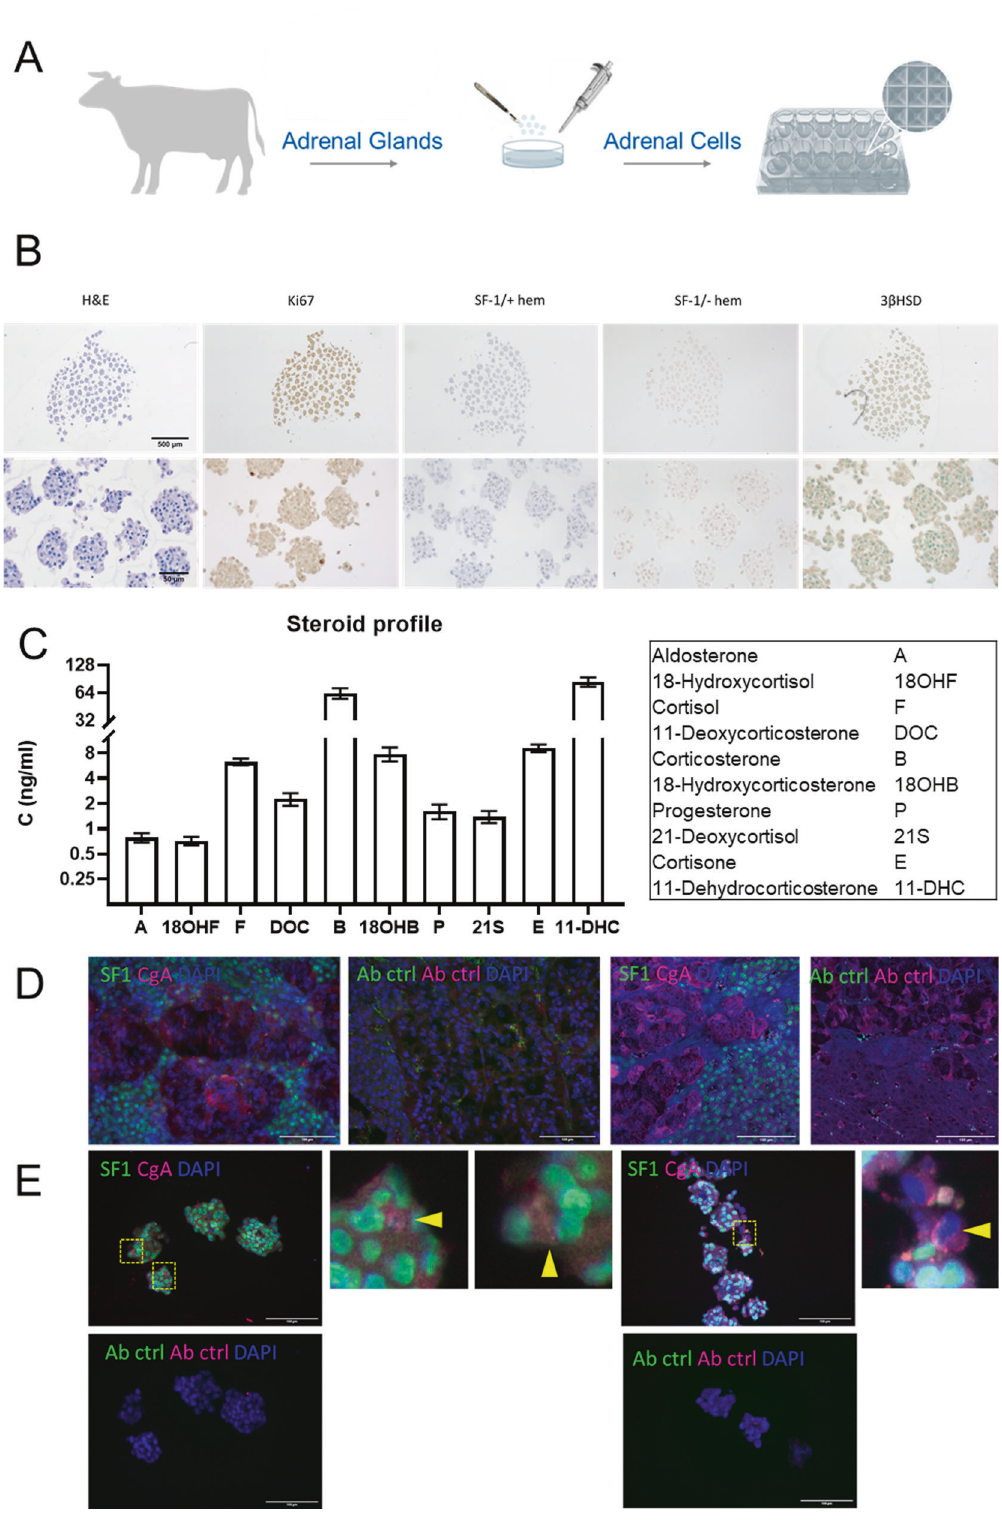
Fig. 6 Successful formation of organoids from bovine cells of adrenocortical and medullary origin. Scheme depicting experimental set up A . Organoids processed for H&E, Ki67, SF-1 (with and without hematoxylin counterstain) and 3bHSD staining at two different magni fi cations B . Secretory pro fi le of organoids derived from a bovine adrenal gland as analyzed by LC-MS/MS ( n = 3) C . Bovine adrenal sections stained with antibodies against SF-1 and chromogranin A (CgA), scale 100 µm D . Adrenocortical and medullary cells in organoids labeled with SF-1 and chromogranin A, scale 100 µm E